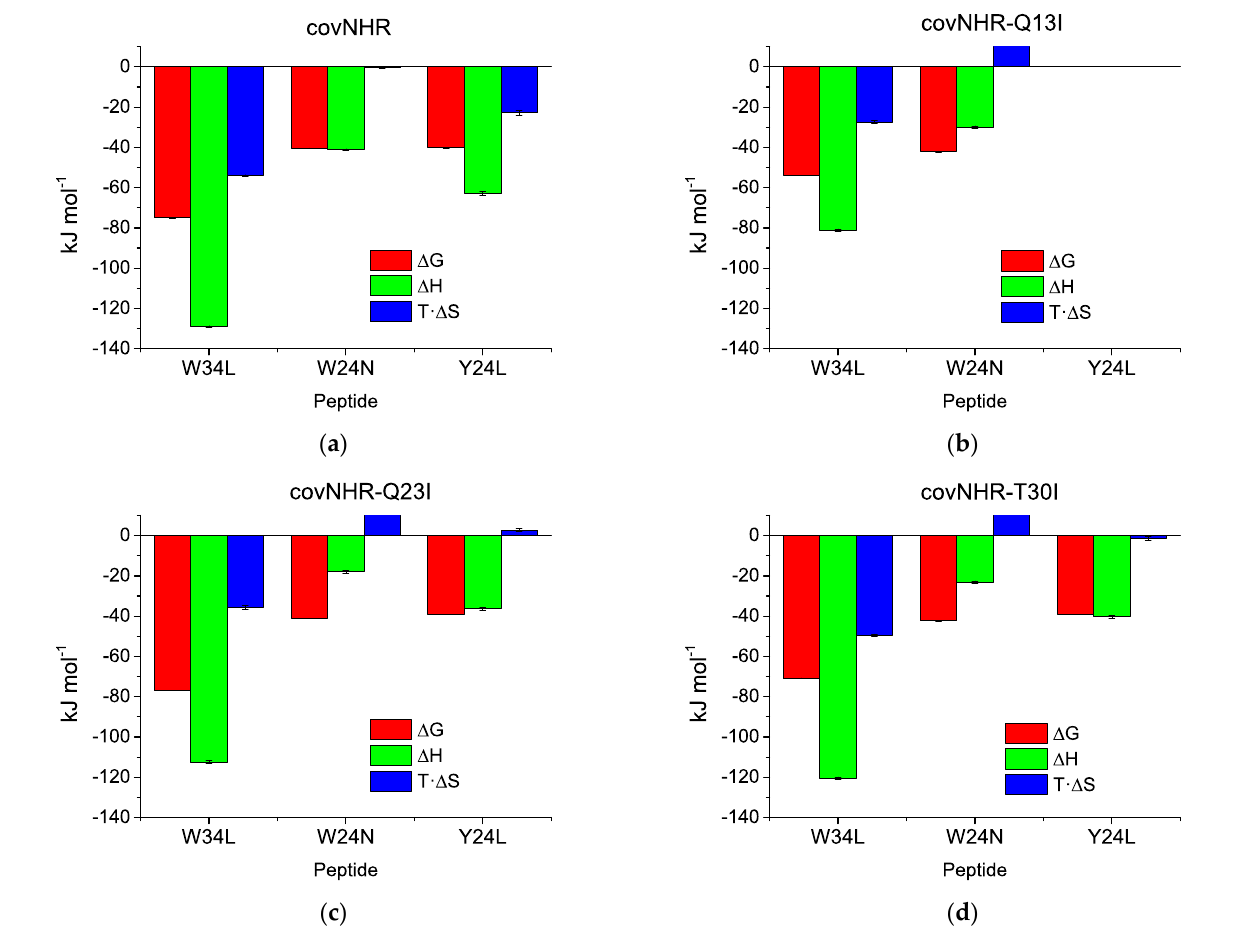
Figure 6. Thermodynamic signature of the binding of CHR peptides to the covNHR proteins. Enthalpy, entropy, and Gibbs energy of binding were obtained from parameters listed in Table 1. ( a ) Reference covNHR protein; ( b ) covNHR-Q13I; ( c ) covNHR-Q23I; ( d ) covNHR-T30I.